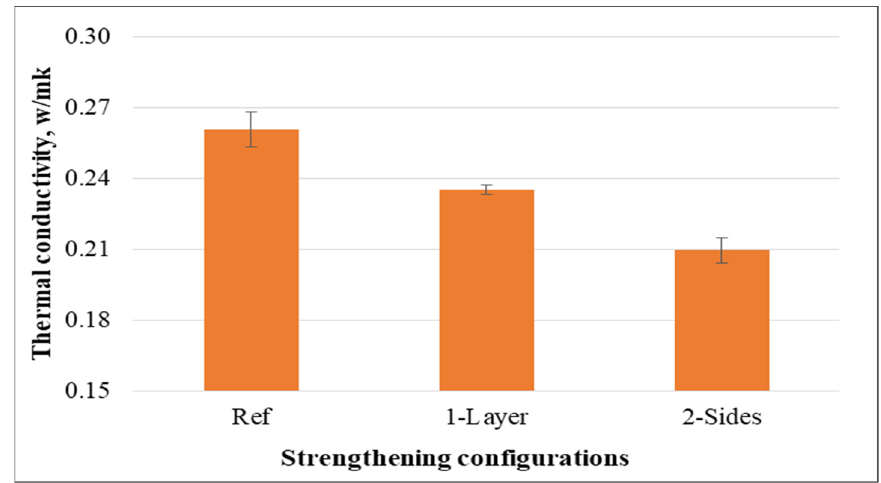
Figure 12. Thermal conductivity of concrete specimens.